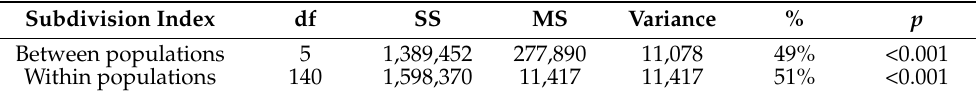
Table 8. Assessment of genetic intra- and interpopulation variability in P. sibirica populations by AMOVA.